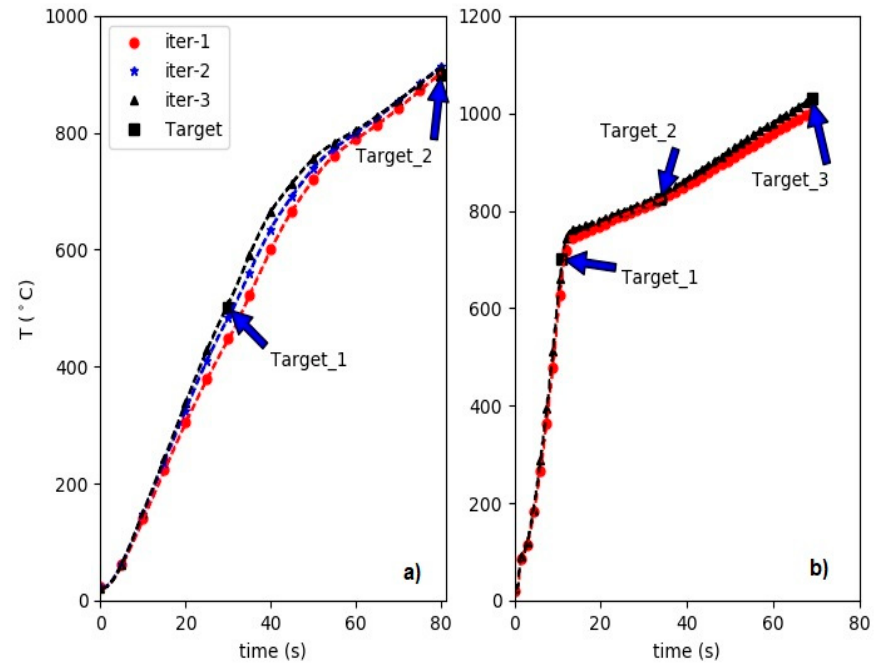
Figure 8. Illustration of two control experiments assisted by the inverse model. ( a ) Two target temperatures T = {500, 900 } ◦ C are set for times t = {30, 80} s. ( b ) Target temperatures T = {700, 825, 1030 } ◦ C are set for times t = {11, 34, 69} s.